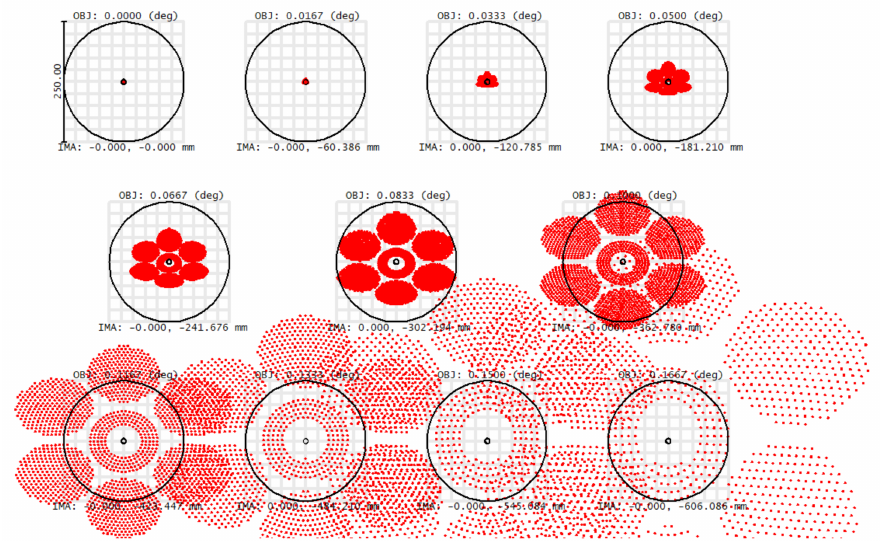
Figure 2. Spot diagram for GMT in 1 arcminute radial field increments from on-axis to 10 arcminutes off axis. The circle size is 0.25 arcseconds. The increase in image size with field is almost purely quadratic, and due to third-order astigmatism. The seeing limit can be seen to be reached at a field radius of 0.08333 degrees, corresponding to the 10 arc-min field diameter described